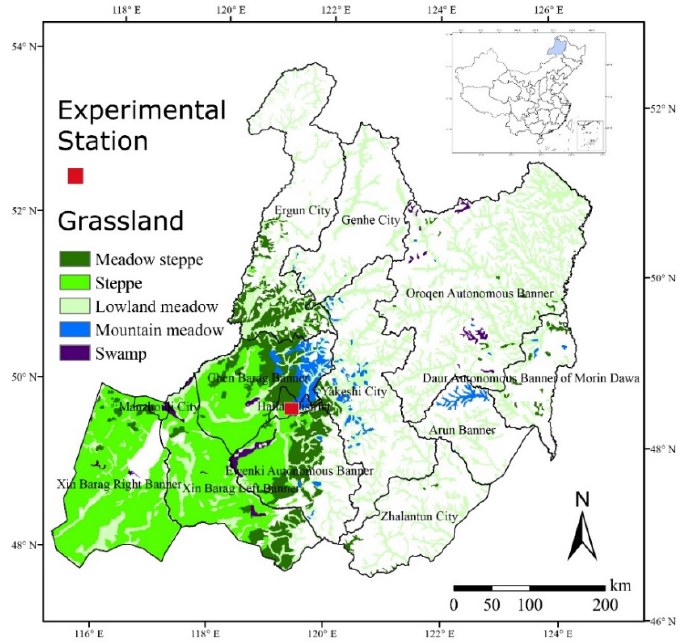
Figure 1. Location of the experimental station in relation to the spatial distribution of grasslands in Hulunbuir. Inset: Geographical location of the study area in China.